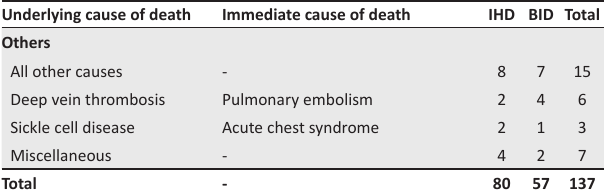
TABLE 4 (Continues...): Summary of non-SARS-CoV-2 related deaths at the 37 Military Hospital, Accra, Ghana, May 2020. Underlying cause of death Immediate cause of death